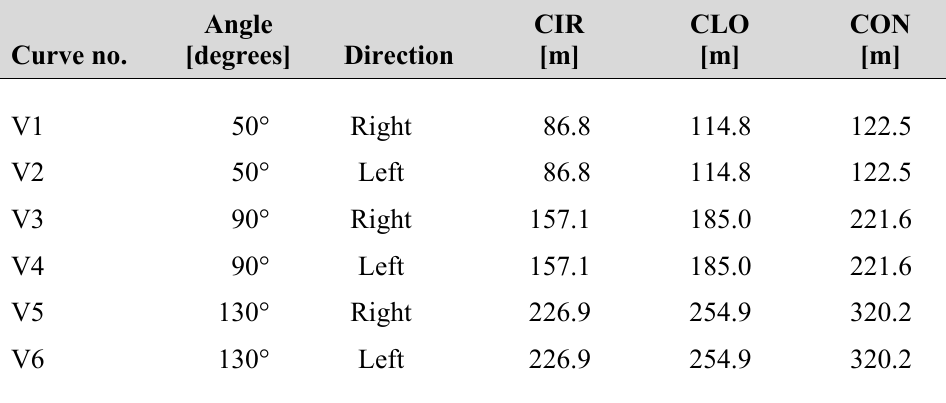
Table 2 Lengths of the three types of curves according to the deviation angle and the curves direction